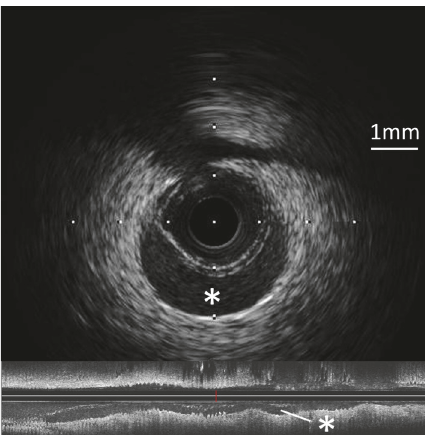
Figure 6: IVUS after fenestration with a scoring balloon showed the resolution of the hyperechoic area within the hematoma space ( ∗ ).